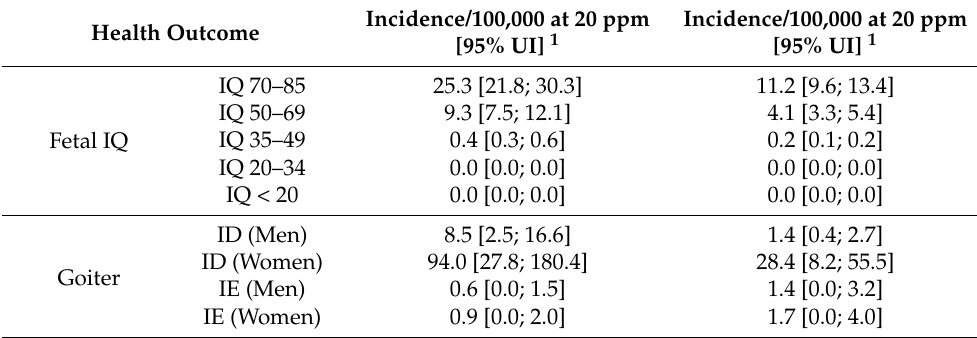
Table 5. Annual mean incidence per 100.000 adult population for each health effect caused by iodine deficiency (ID) and iodine excess (IE) at 13 and 20 ppm fortification